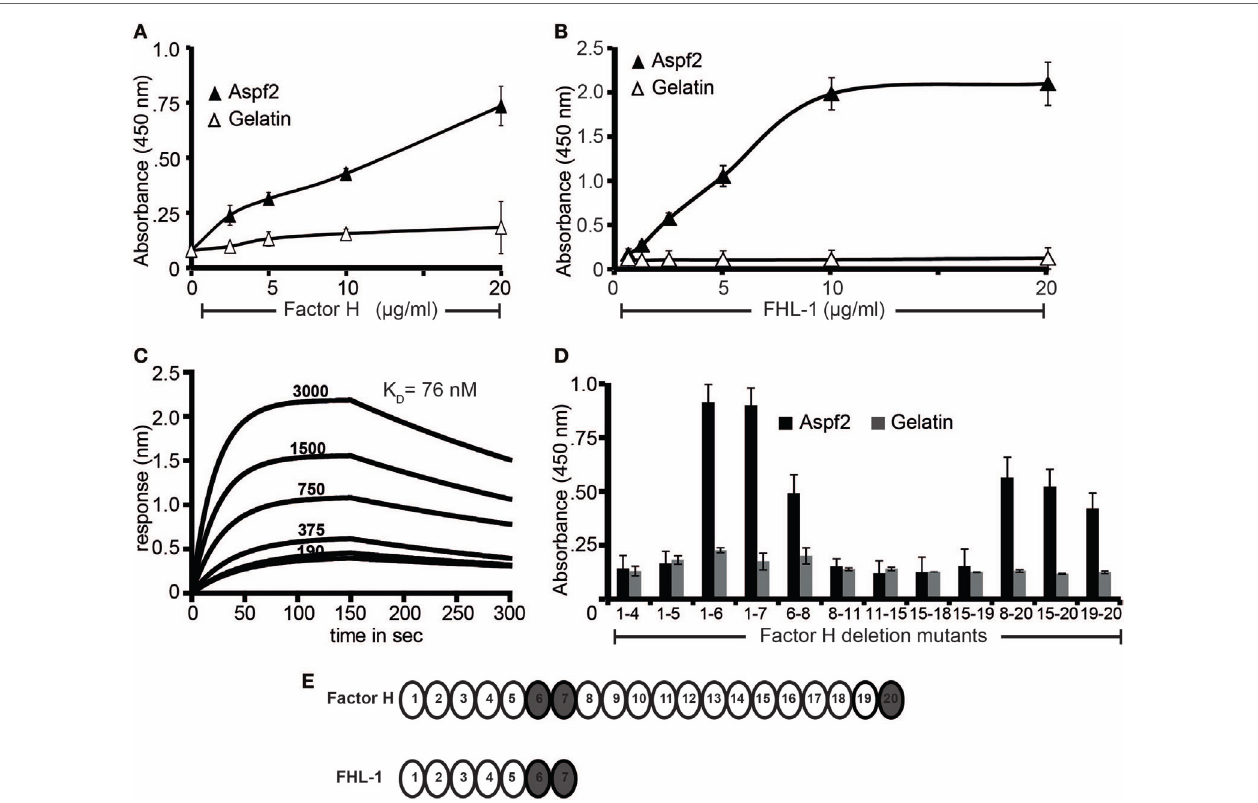
FigUre 1 | Recombinant Aspf2 binds to Factor H and factor-H-like protein 1 (FHL-1). (a) Aspf2 binds to Factor H dose-dependently. Aspf2 binding to Factor H was assayed by enzyme-linked immunosorbent assay (ELISA). Factor H was immobilized onto a microtiter plate, and Aspf2 at the indicated amounts was added. After washing, bound Aspf2 was detected with mAb Aspf2. Aspf2 did not bind to gelatin. (B) Aspf2 binds to FHL-1 dose-dependently. Aspf2 at increasing amounts was added to immobilized FHL-1, and bound Aspf2 was detected by with mAb Aspf2. Aspf2 did not bind to gelatin. (c) Factor H binds to Aspf2 with high affinity. The binding affinity of Factor H to Aspf2 was evaluated by biolayer interferometry. Aspf2 was coupled to the surface of NTA biosensors, and Factor H at 190, 375, 750, 1,500, and 3,000 nM concentrations was added as analyte. For each concentration, the association of complex was assessed for 150 s, and the dissociation was evaluated for 150 s. Factor H binds to Aspf2 with a K D of 76 nM. Heat-inactivated (95°C) Factor H did not bind to Aspf2 (bottom line) (D) Mapping of Aspf2-binding regions within Factor H and FHL-1. Binding of Aspf2 to the indicated Factor H/FHL-1 deletion mutants was investigated by ELISA. Aspf2 was added to immobilized Factor H/FHL-1 deletion mutants, and bound Aspf2 was detected by mouse Aspf2 anti-serum. Aspf2 binds to Factor H via SCR6–7 and SCR20 and to FHL-1 through SCR6–7. (e) The structure of Factor H and FHL-1 are shown with their corresponding domains short consensus repeats (SCR). Aspf2-binding domains are highlighted in brown . Panels A, B, and D represent mean ± SD of three independent